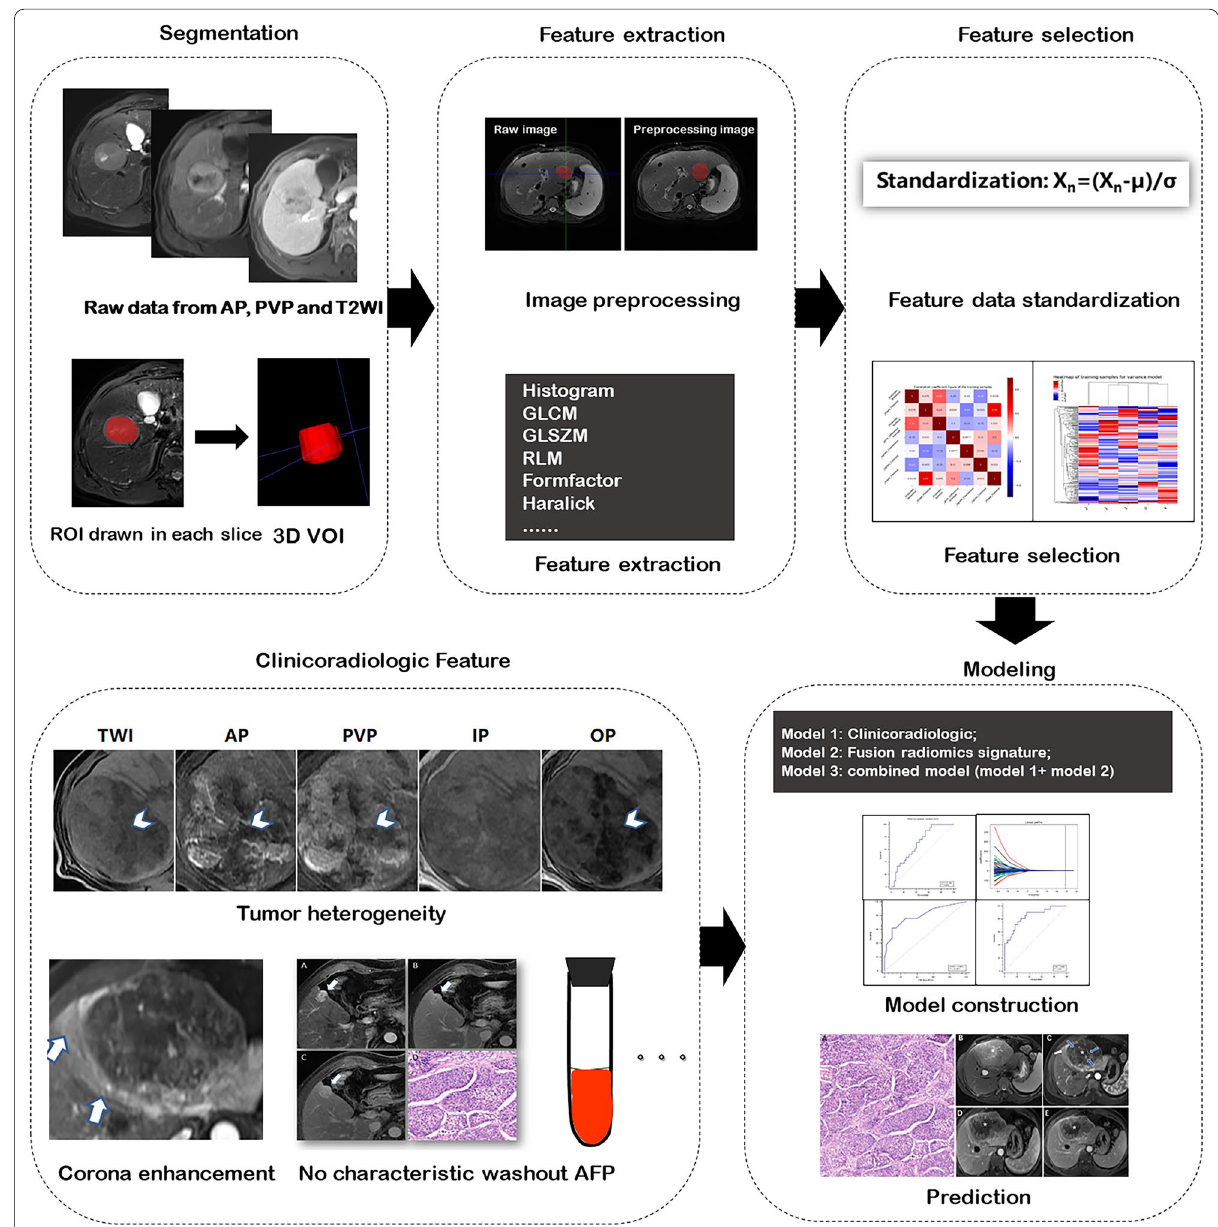
Fig. 3 Workflow of model